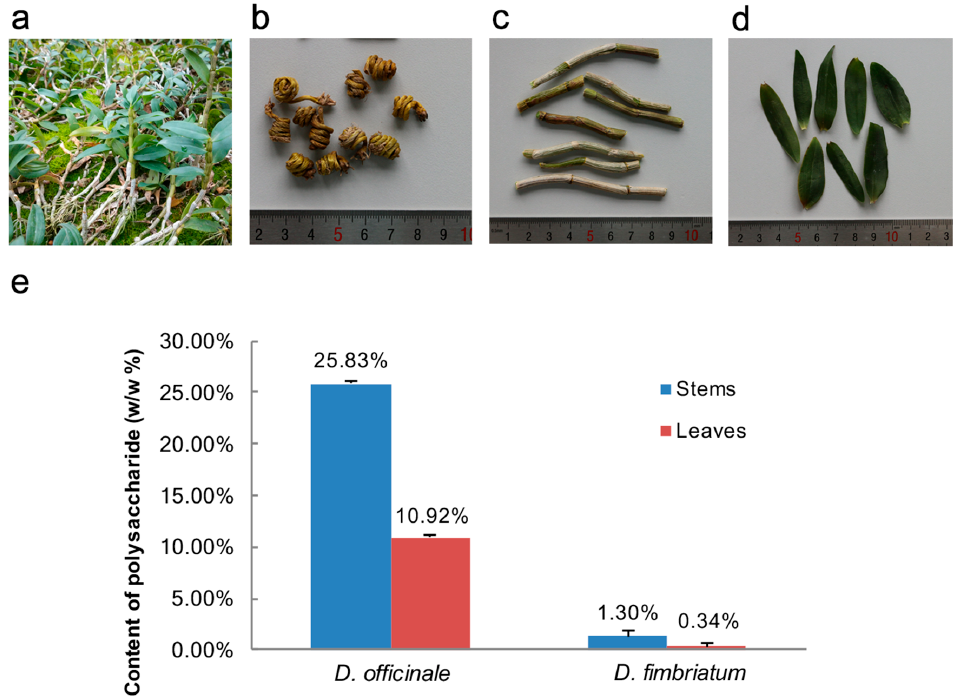
Figure 1. Morphology and chemical profiling of the leaves and stems of Dendrobium officinale